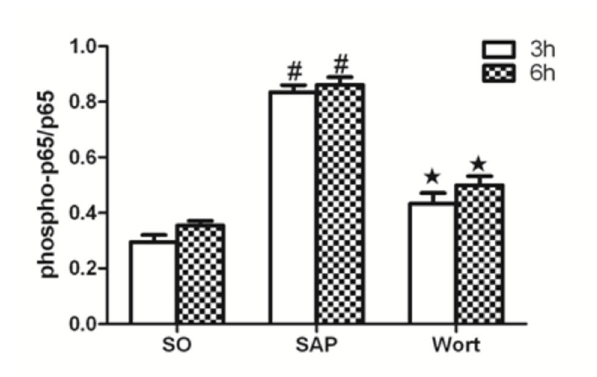
Figure 9. Akt mRNA expression in each group at the 3 h and 6 h time point. # P <0.05 vs. SO group; ★ P <0.05 vs. SAP group.